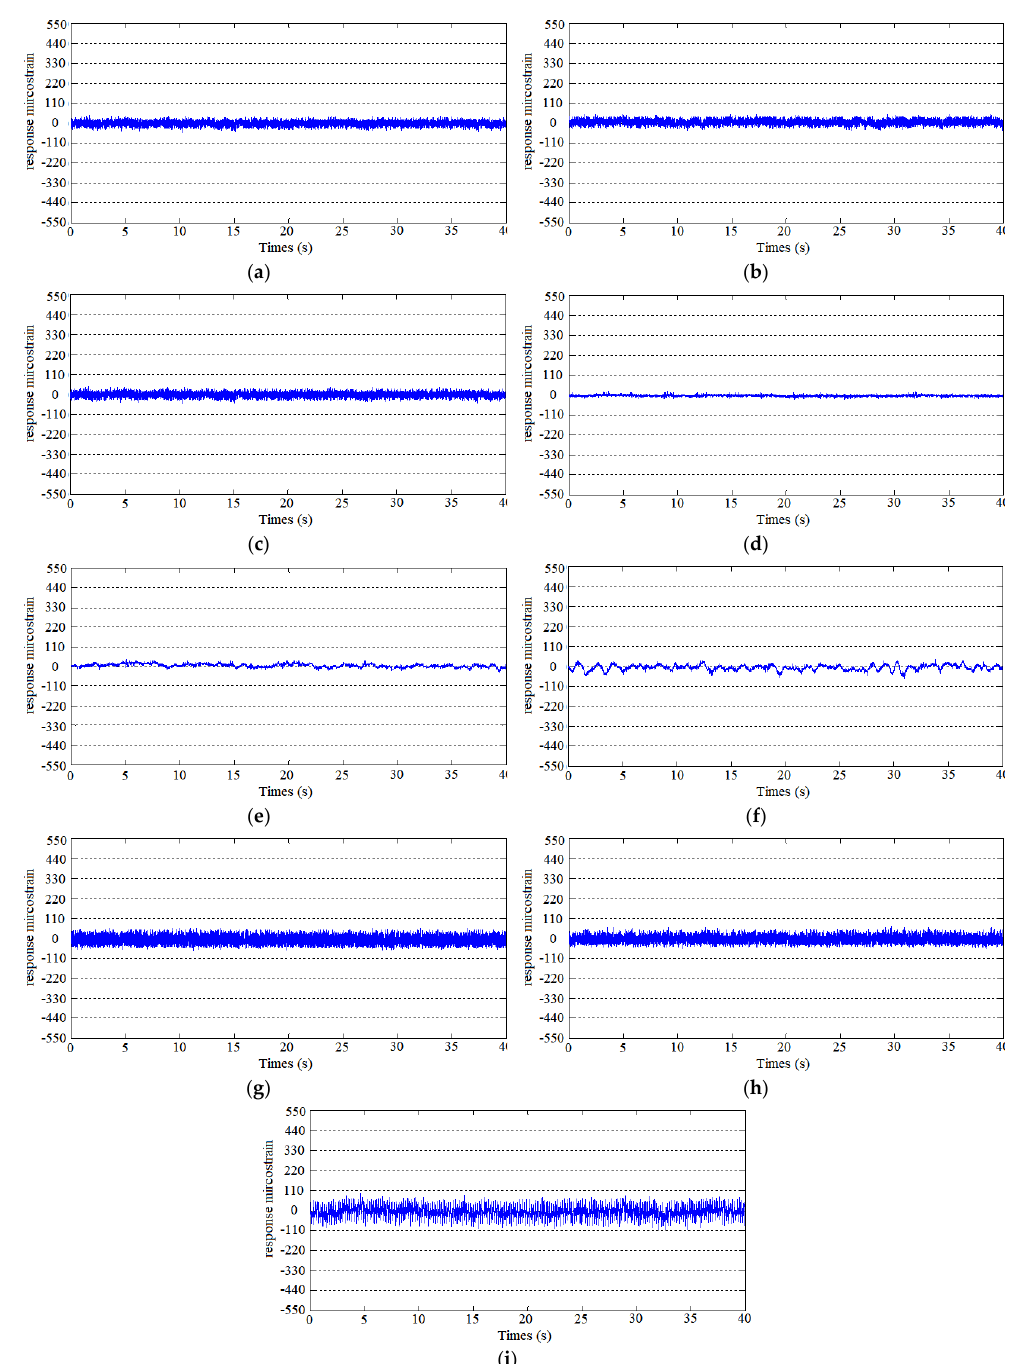
Figure 5. Response microstrain curves of the three risers at z = 0.5 m with 65 N top tension force and S –S end condition. ( a ) 0.2 m/s, Al, case 7; ( b ) 0.6 m/s, Al, case 8; ( c ) 1.0 m/s, Al, case 9; ( d ) 0.2 m/s, PMMA, case 19; ( e ) 0.6 m/s, PMMA, case 20; ( f ) 1.0 m/s, PMMA, case 21; ( g ) 0.2 m/s, UPVC, case 31; ( h ) 0.6 m/s, UPVC, case 32; ( i ) 1.0 m/s, UPVC, case